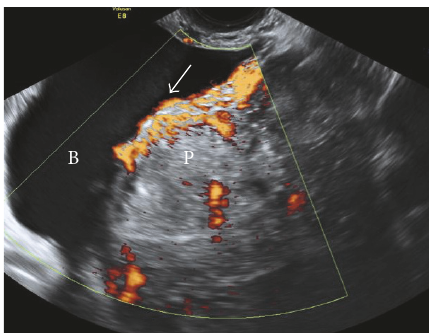
Figure 3: Ongoing evidence of adherent placenta (P) with likely bladder (B) invasion (arrowed) and dilated vesical and uterine vessels.